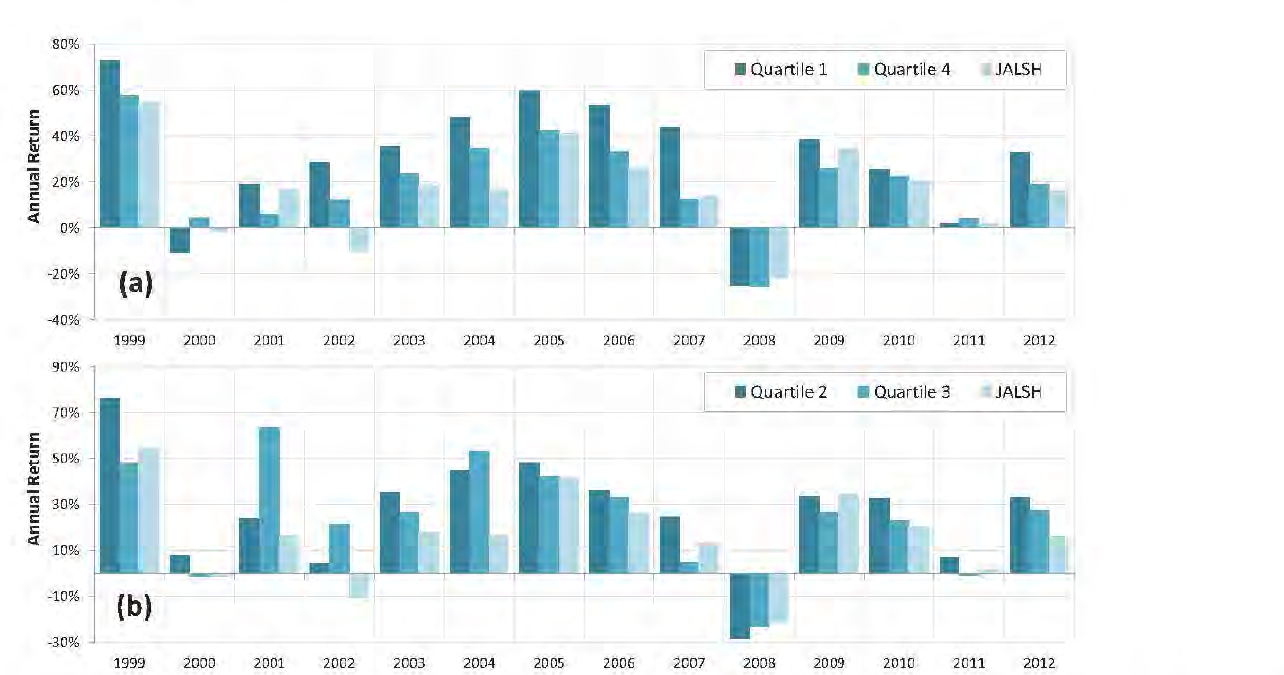
Figure 4: Portfolio and JALSH returns by year for value and growth stocks based on DY, 1999-2012 for (a) quartiles 1 and 4 and (b) quartiles 2 and